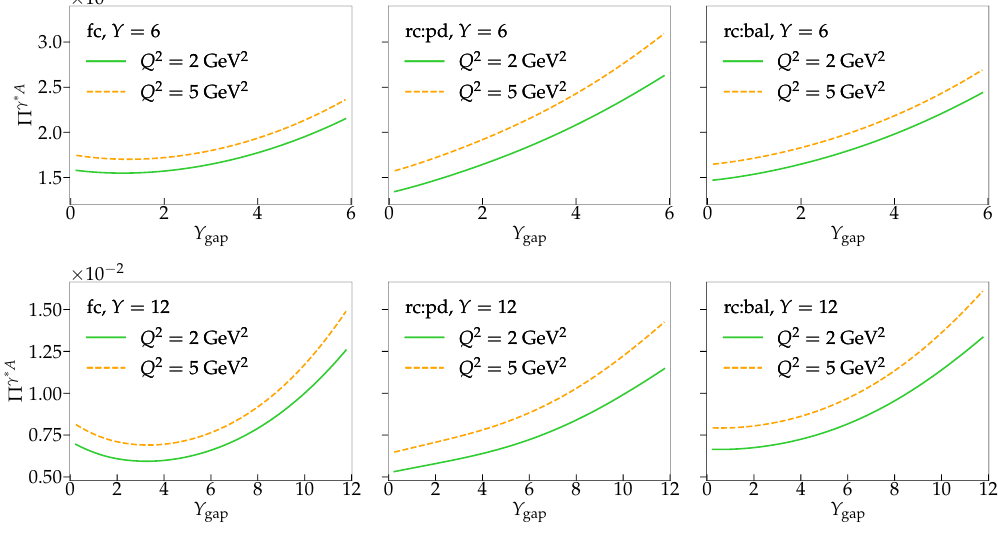
Figure 2: Rapidity gap distribution for different values of the total rapidity Y and of the virtuality Q 2 . A = 208 is set for the nuclear mass